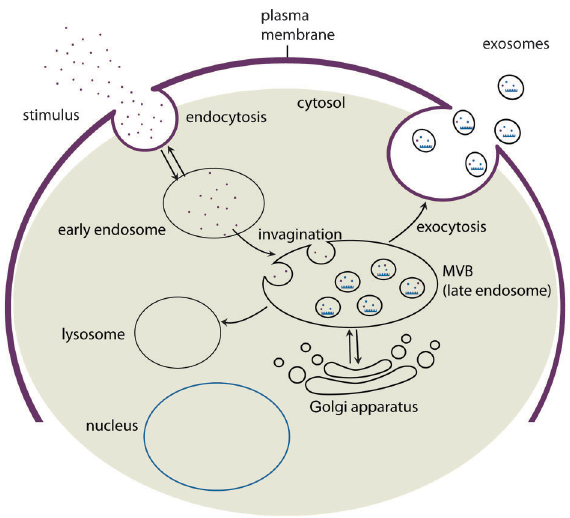
Figure 1. Early endosomes (EE) are formed by endocytosis following microenvironment modifications. The EE undergo maturation forming the late endosome or multivesicular body (MVB). During this process, EE communicate with the Golgi apparatus through bidirectional vesicle exchange. Inward bud- ding of the membrane forms the intraluminal vesicles that will be released to the extracellular space as exosomes, or will fuse with lysosomes where an active degradation process will take